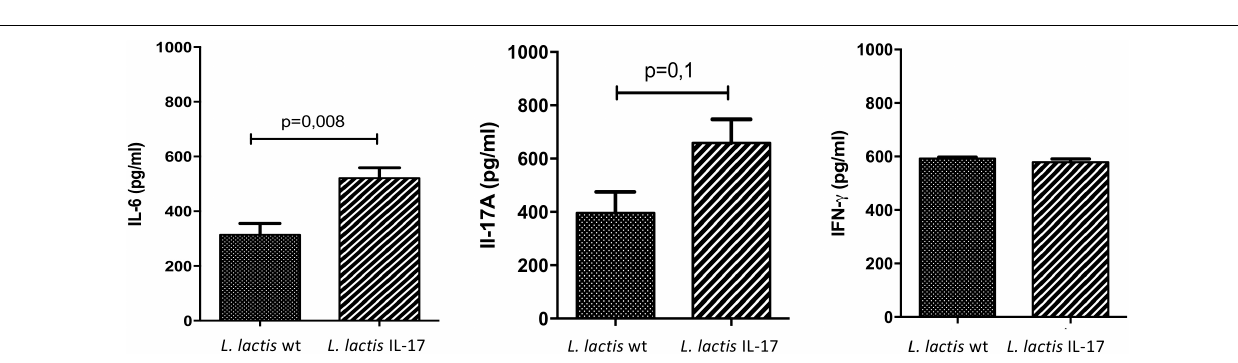
FIGURE 4 | Cytokines production by reactivated splenocytes from mice treated with recombinant bacteria and challenged with TC-1 cells. Splenocytes were stimulated for 48 h with PMA ionomycin before measuring cytokines levels. Data represented mean ± SEM from 4 ( L. lactis wt) to 8 mice ( L. lactis IL-17). Data are analyzed with unpaired t -test followed by Mann–Withney